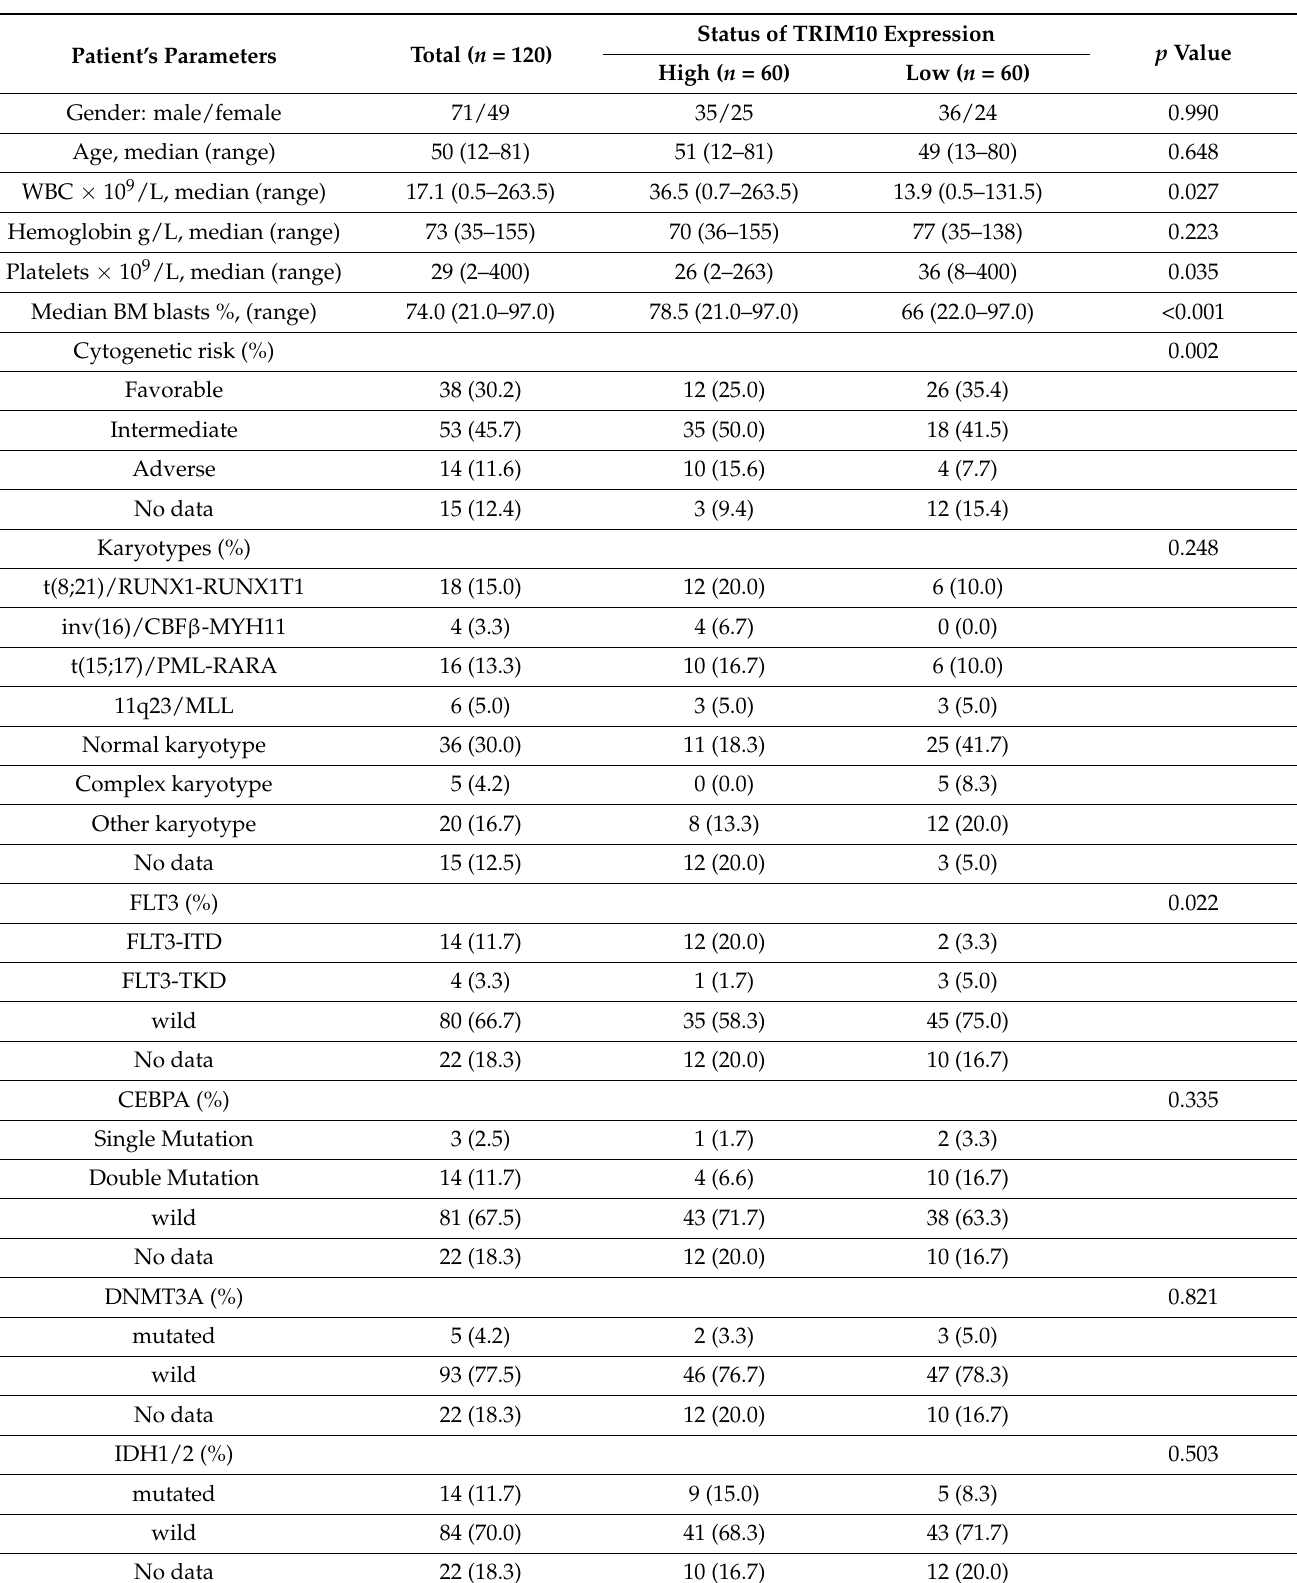
Table 1. Correlation of TRIM10 expression with clinical and laboratorial parameters in AML